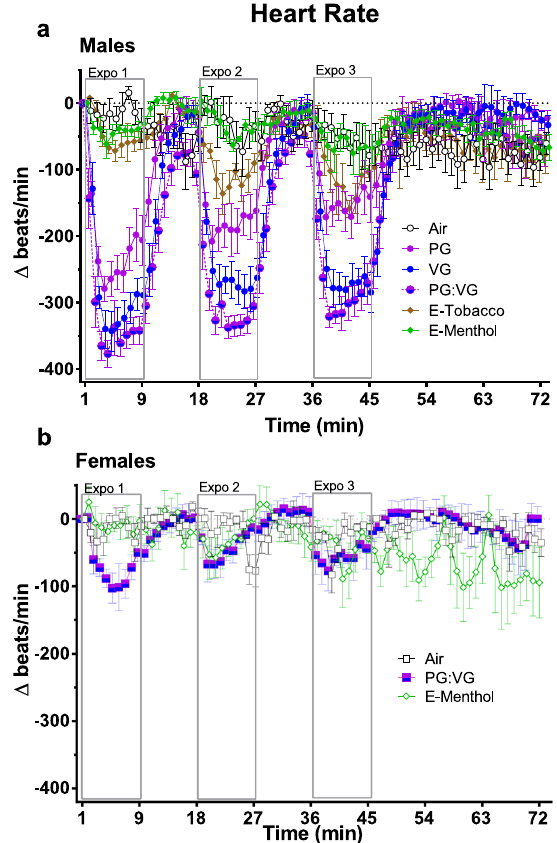
Fig. 1 | Timecourse of E-cig-induced alterations in heart rate by sex. Values represent 1-min simple means (±SEM) of change from 5-min baseline in heart rate duringthree9-mininhalationexposurestoe-cigsolvents(PG,VG,andPG:VG, n =8 male mice/exposure) or commercial e-liquids (E-Tobacco and E-Menthol, 2.4% freebase nicotine, n =4 and n =7 male mice, a , respectively). For all female expo- sures ( b ), n =4 mice. Tall open boxes denote 9-min puff sessions (expo). Source data are provided as a Source Data fi